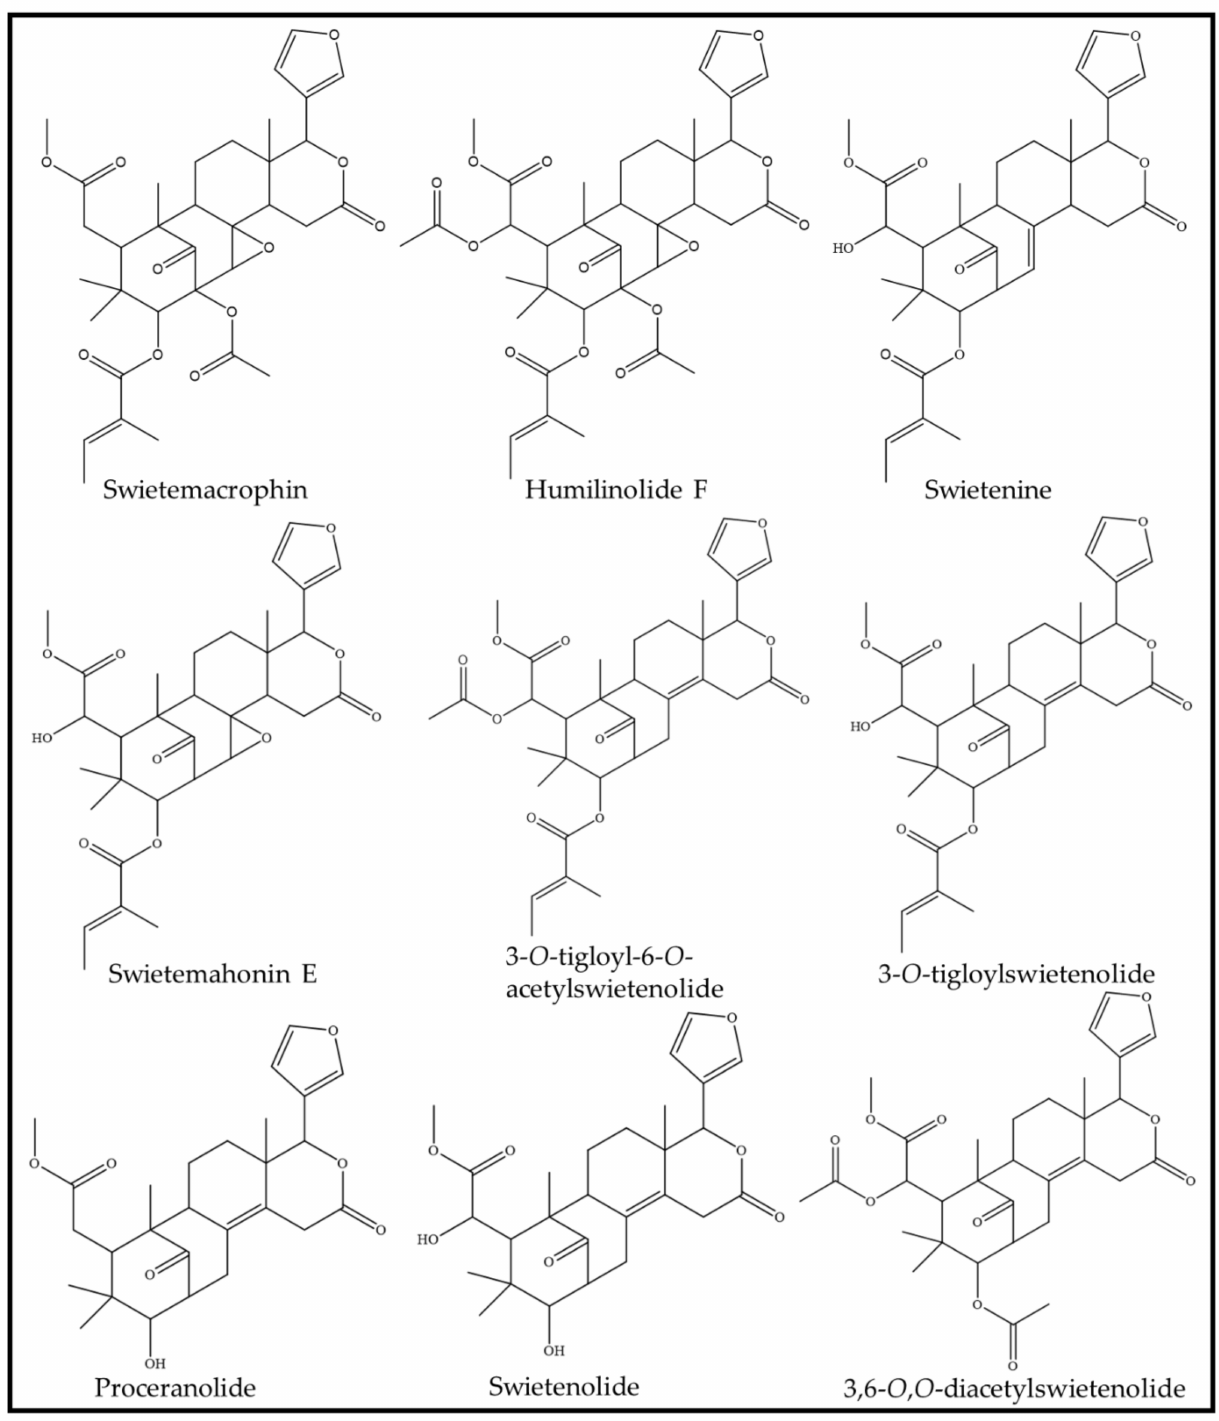
Figure 1. Limonoid phytocompounds extracted from S. macrophylla seed with cosmeceutical